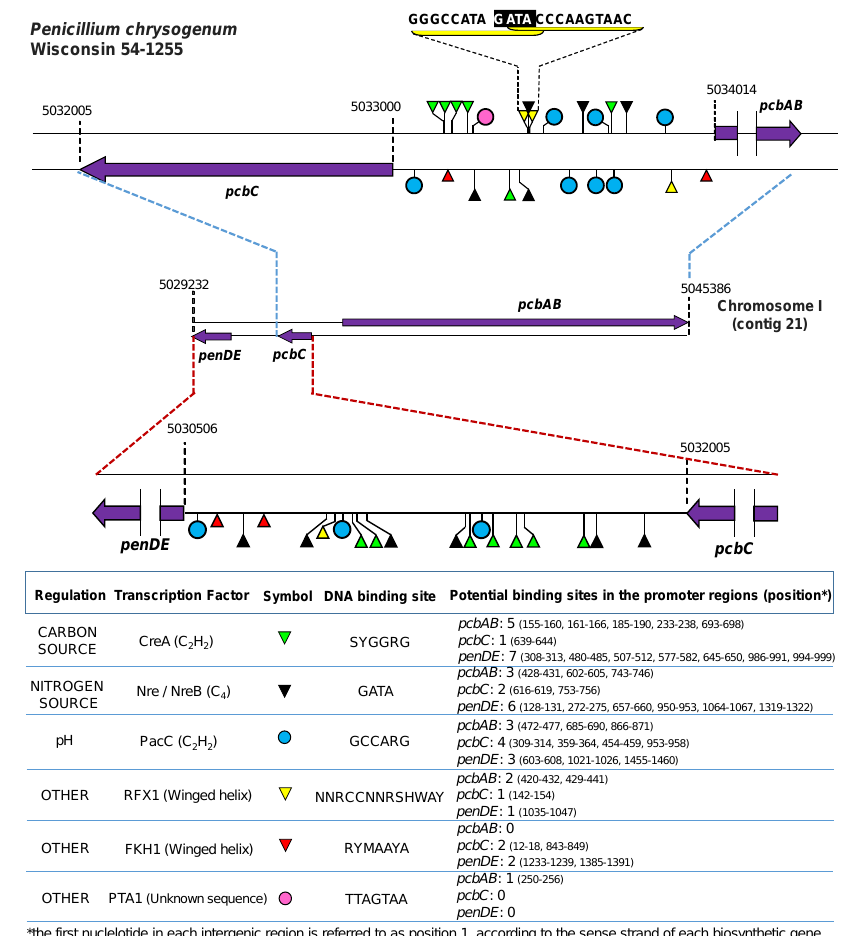
Figure 1. Schematic representation of the promoter regions of the benzylpenicillin gene cluster and potential binding sites for some transcription factors. Numbers above genes indicate positions within contig 21 of the P. chrysogenum Wisconsin 54–1255 genome.